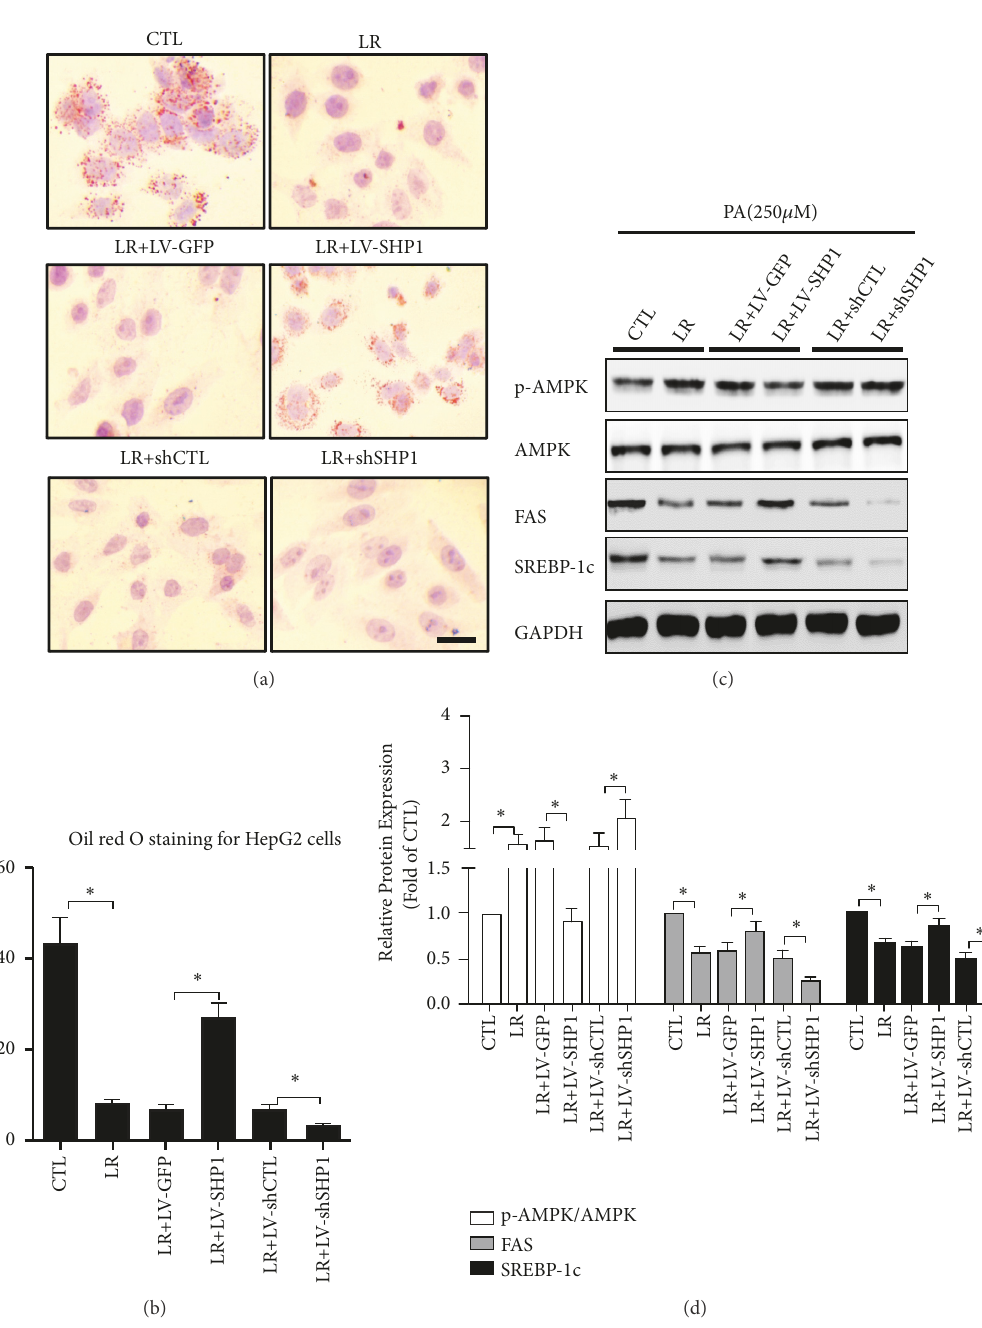
Figure 4: SHP1/AMPK pathway was involved in relieving effects of liraglutide on hepatocellular steatosis in vitro . (a) HepG2 cells were cultured in FBS-free DMEM with 250 nmol/L PA in 24 hours and then exposed to liraglutide for 24 hours after cells had been transfected by LV-SHP or control LV-GFP, shSHP, and control shCTL. And cells were stained with Oil Red O and photographed under the microscope (magnification × 200, scale 20 𝜇 m). (b) Intracellular lipid accumulation was quantified by semiquantitative analysis. The rate of cell with positive area is shown as mean ± SD of three independent experiments. (c) The changes of levels of AMPK pathway proteins and lipid lipogenesis proteins in all groups. FAS, SREBP-1c, p-AMPK, AMPK, p-ACC, and ACC were detected by western blot and the representative images are shown. (d) The densitometry ratio of FAS/GAPDH, SREBP-1c/GAPDH, p-AMPK/AMPK, and p-ACC/ACC are shown as mean ± SD of three independent experiments. The western blot results were normalized to the control value. ∗ denotes P <